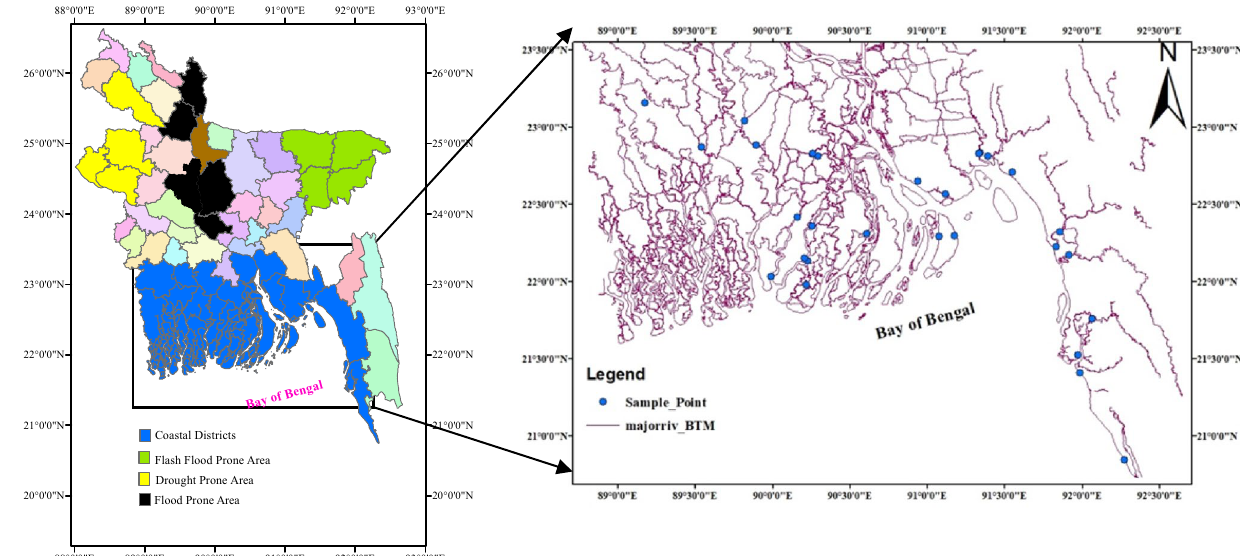
Fig. 1 Map of sampling sites and coastal area of